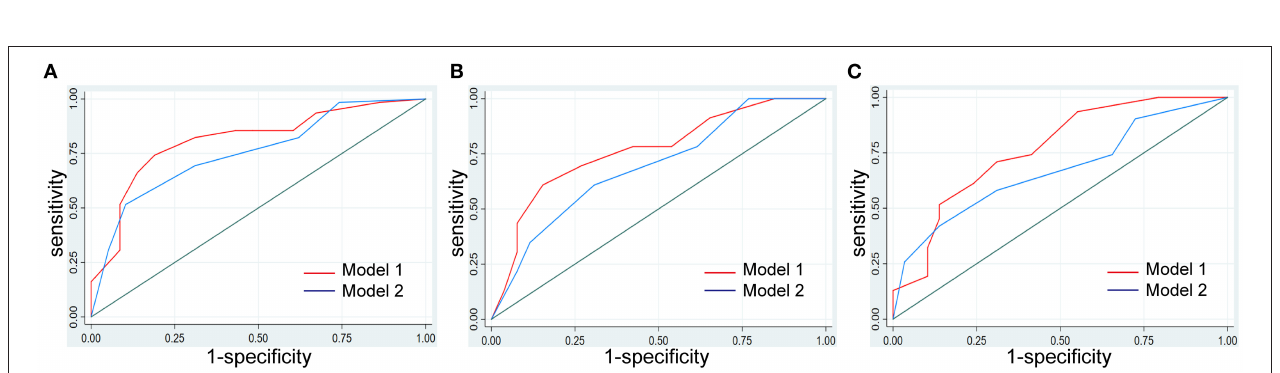
FIGURE 4 | Model development and comparison. The model with AA of multilobulated contour identified as a new independent predictor improved the identification performance for risk classification of thymoma compared with the model without AA. (A) Comparison of the performance of the models in the training cohort. (B) Comparison of the performance of the models in the internal validation cohort. (C) Comparison of the performance of the models in the external validation cohort.